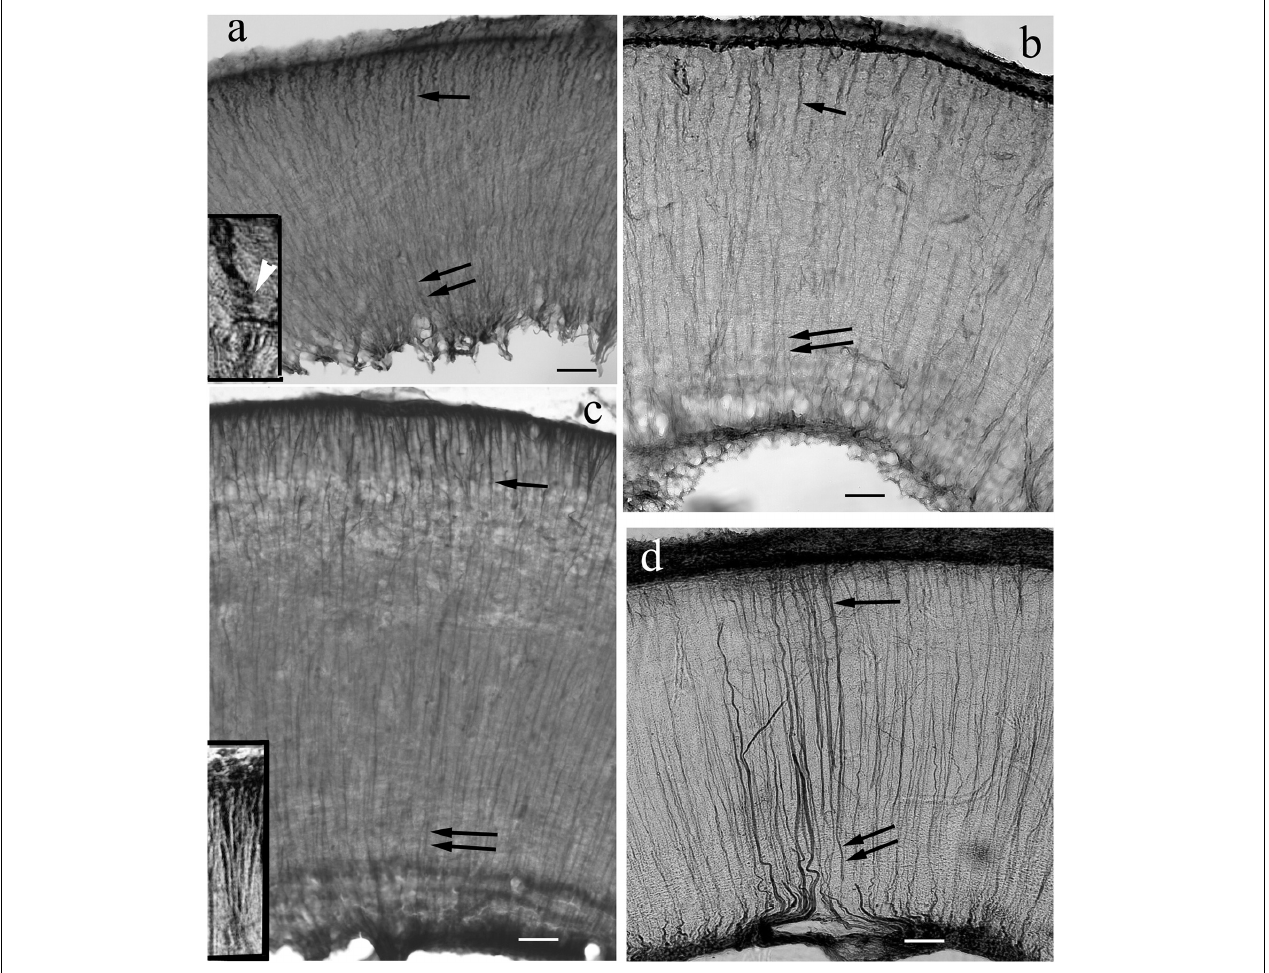
FIGURE 8 | Tectum details of non-teleosts and basal teleosts: processes are immunostained in full length. The meningeal surfaces are upward. The radial processes are visible both near the surface (arrows) and near the ventricle (double arrows). (a) Bichir. Its wall is thin related to the other species investigated. Toward the meningeal surface the glial processes thicken and get a little spiralized (see inset, white arrowhead points to the coils). Scale bar: 40 µ m, for the inset 15 µ m. (b) Sterlet. The processes thicken toward the meningeal surface. Scale bar: 40 µ m. (c) Gar. Comb-like branching of processes (see enlarged in the inset) below the meningeal surface. Scale bar: 40 µ m, for the inset: 15 µ m. (d) Eel. A thin submeningeal zone is distinguished by fine, dense branches. Scale bar: 40 µ